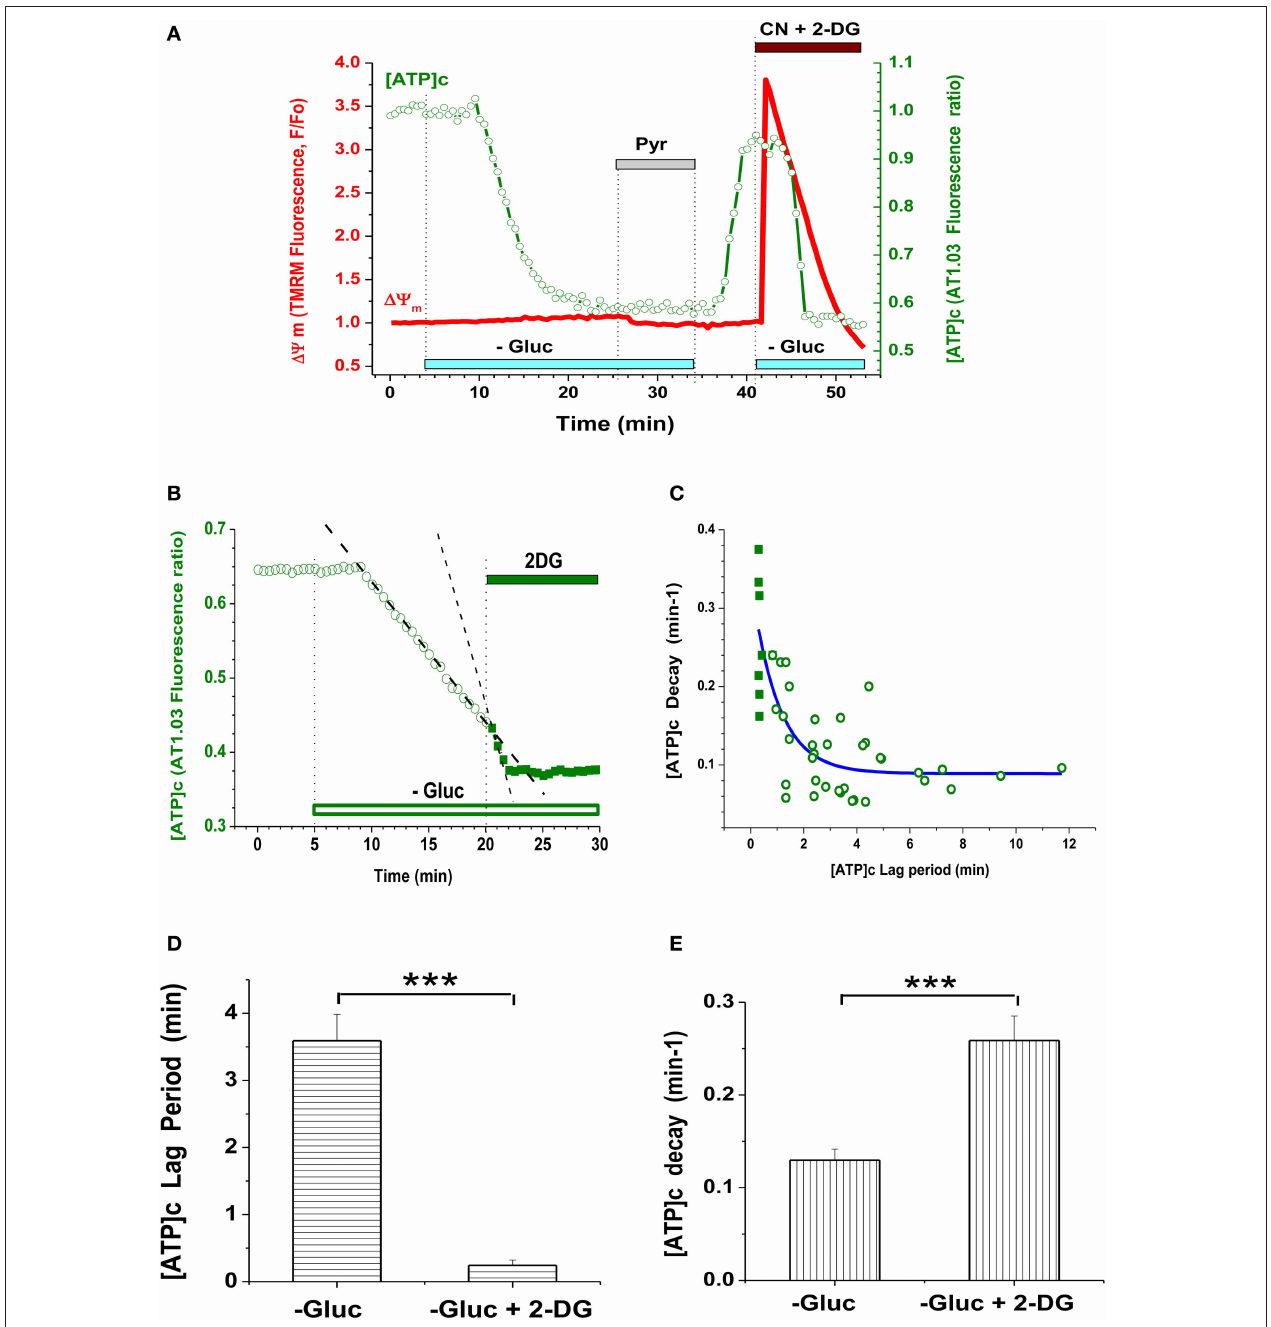
FIGURE 2 | Glycolysis inhibition in embryonic neurons caused depletion of [ATP]c but had little effect on (cid:2)(cid:3) m. (A) Simultaneous measurement of AT1.03 ratio (F436/F500; [ATP]c, green trace, right axis) and TMRM signal ( (cid:2)(cid:3) m, red trace, left axis) during inhibition of glycolysis and/or mitochondrial respiration. Gluc deprivation is indicated with light-blue bars, Pyr (10mM) application with a gray bar, 3mM NaCN and 5mM 2-DG (CN + 2-DG) application with a brown bar. (B) Example of the accelerating effect of glycolysis blockade with 2-DG on the time course of [ATP]c decrease during Gluc deprivation. Application of 2-DG is indicated with a green bar. Linear fit of the [ATP]c trace in prior to and during 2-DG application is shown as dashed lines. (C) Correlative plot of the [ATP]c decay rate (min − 1 ) vs. the lag period of